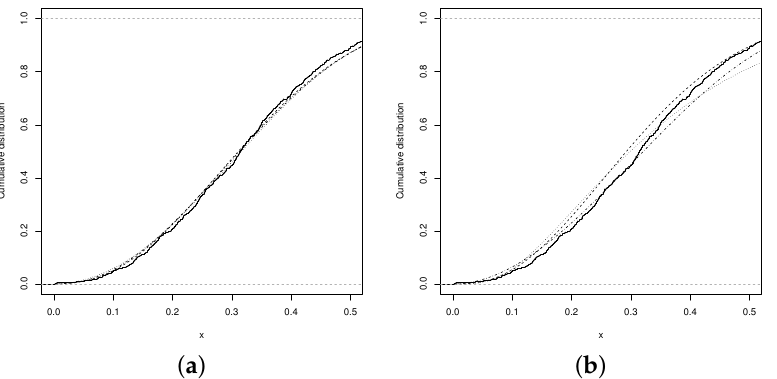
Figure 5. CDF ( a ) USN (dashed line), UPN (dotted line) and UN (dashed and dotted line), ( b ) Beta (dashed line), UW (dotted line) and UBS (dashed and dotted